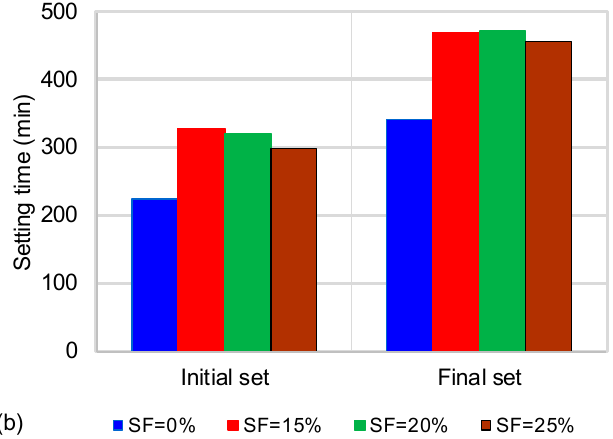
Figure 4. Setting time of key mixtures: ( a ) effect of changing WB for mixtures containing 20% SF; ( b ) effect of changing SF for the mixtures with WB = 0.22.